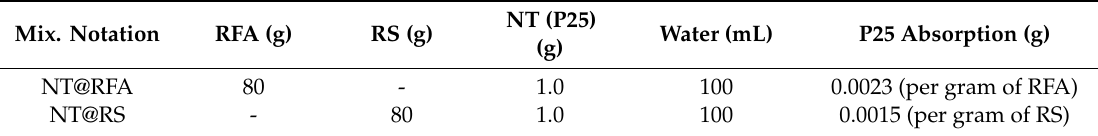
Table 2. Mixture proportions of different CPs.